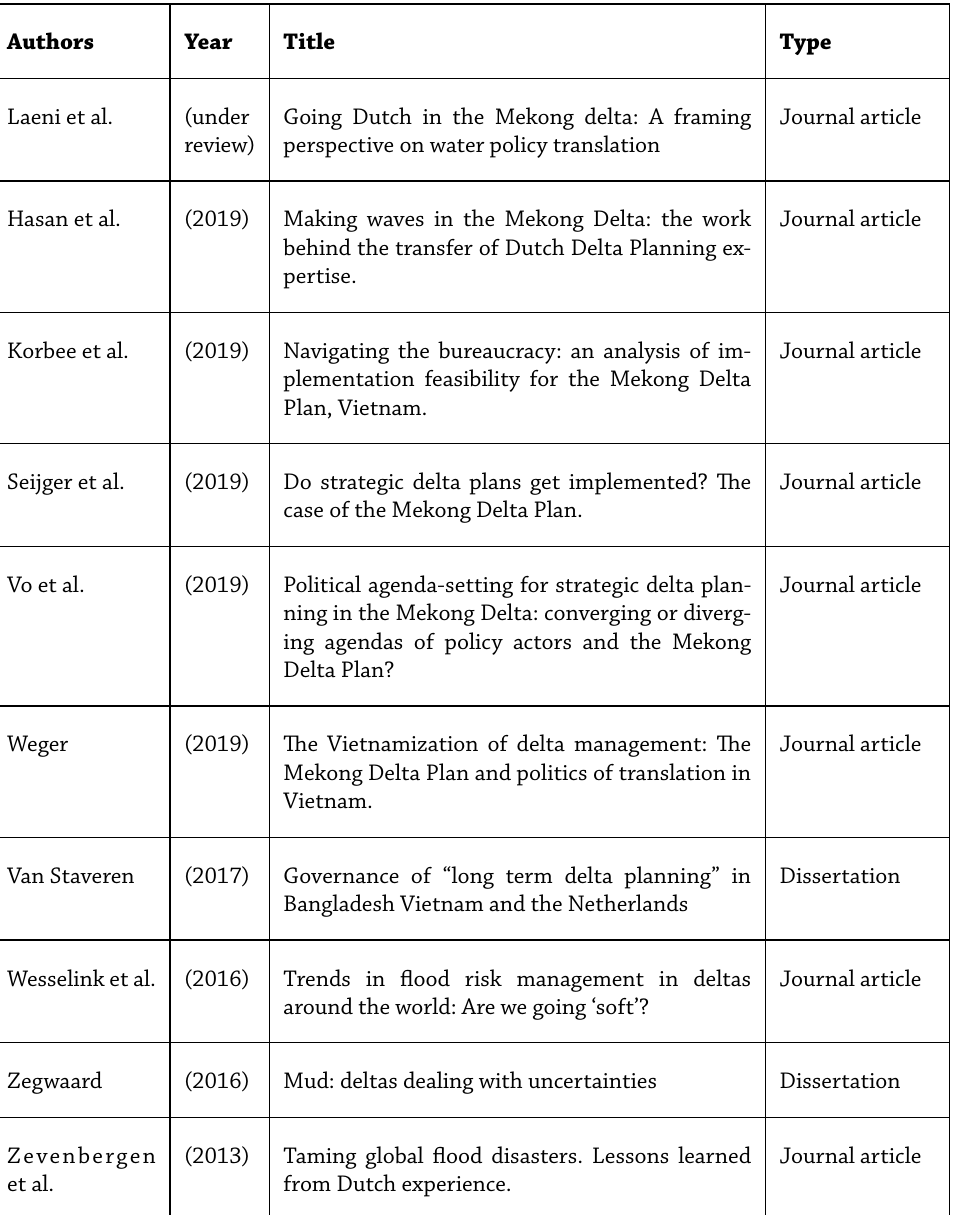
Table A.1 Overview of literature on the Mekong Delta Plan